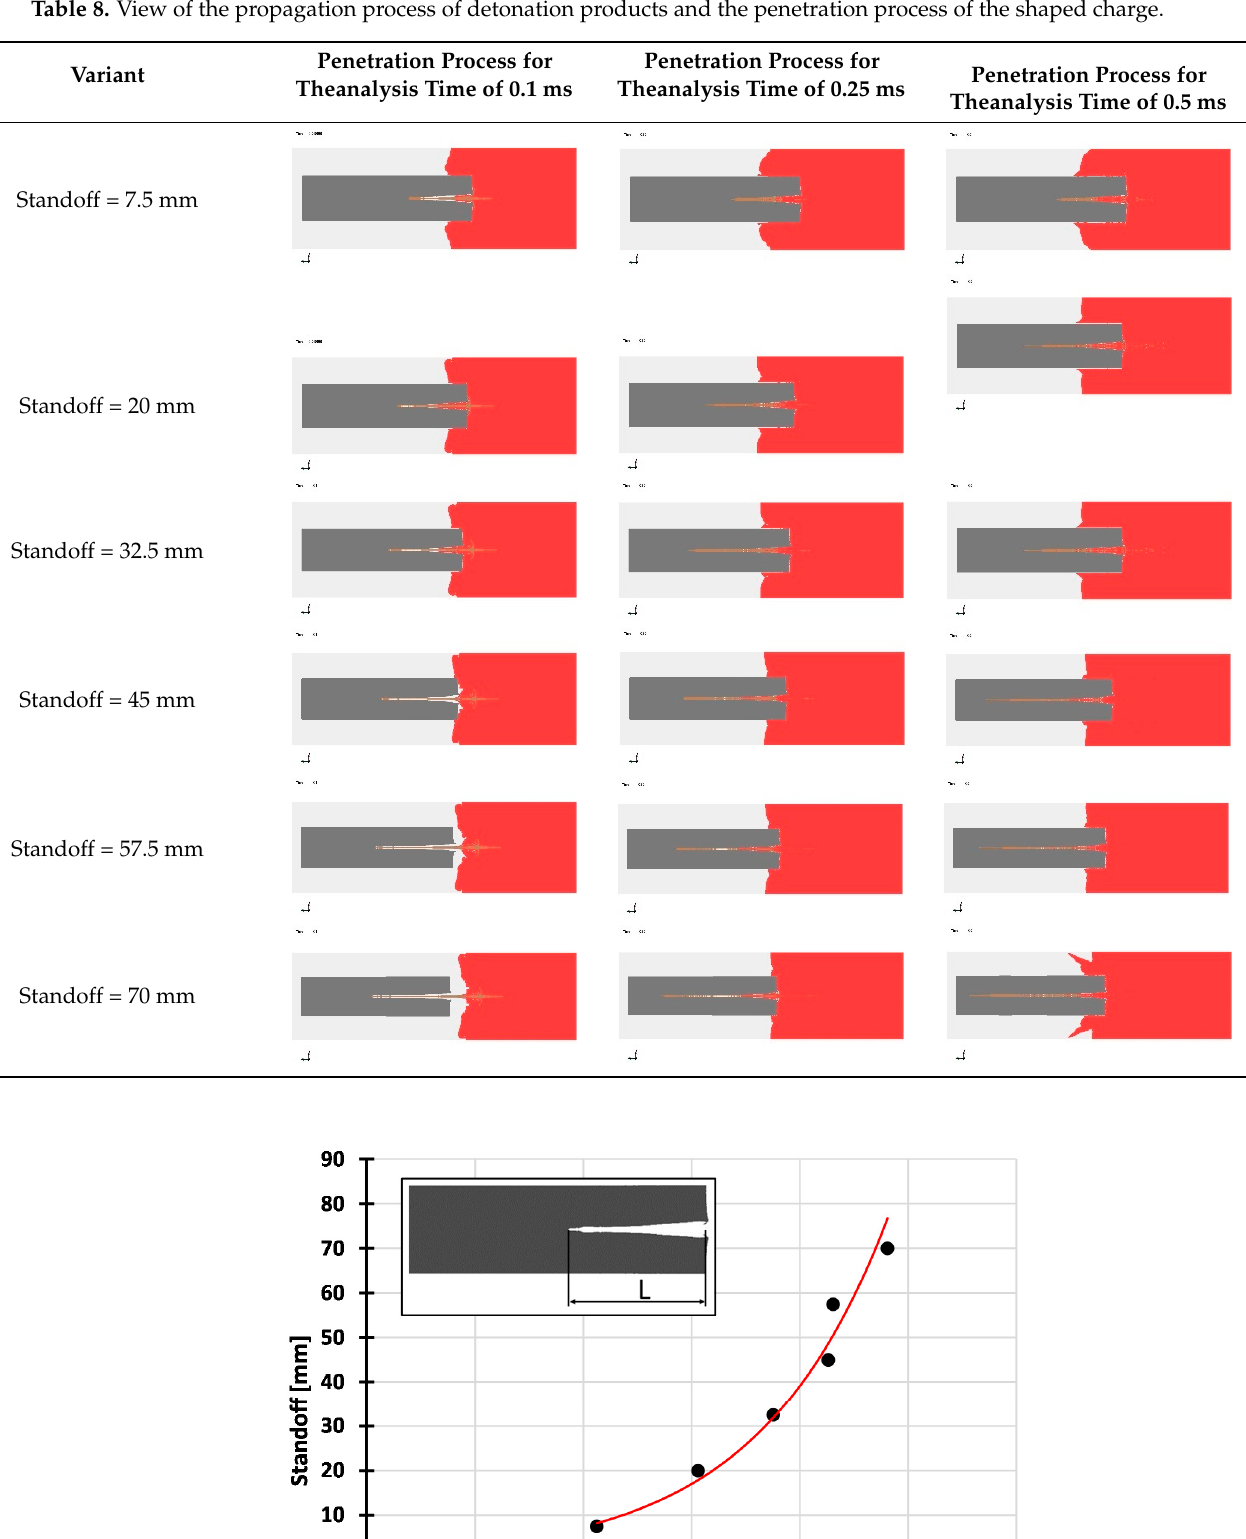
Table 8. View of the propagation process of detonation products and the penetration process of the shaped charge.